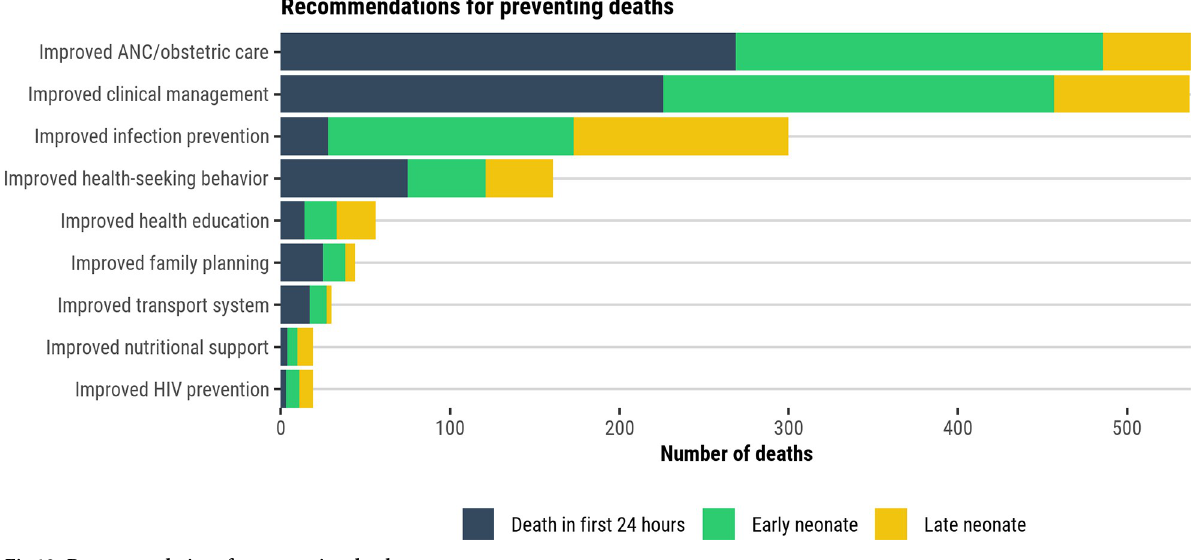
Fig 10. Recommendations for preventing